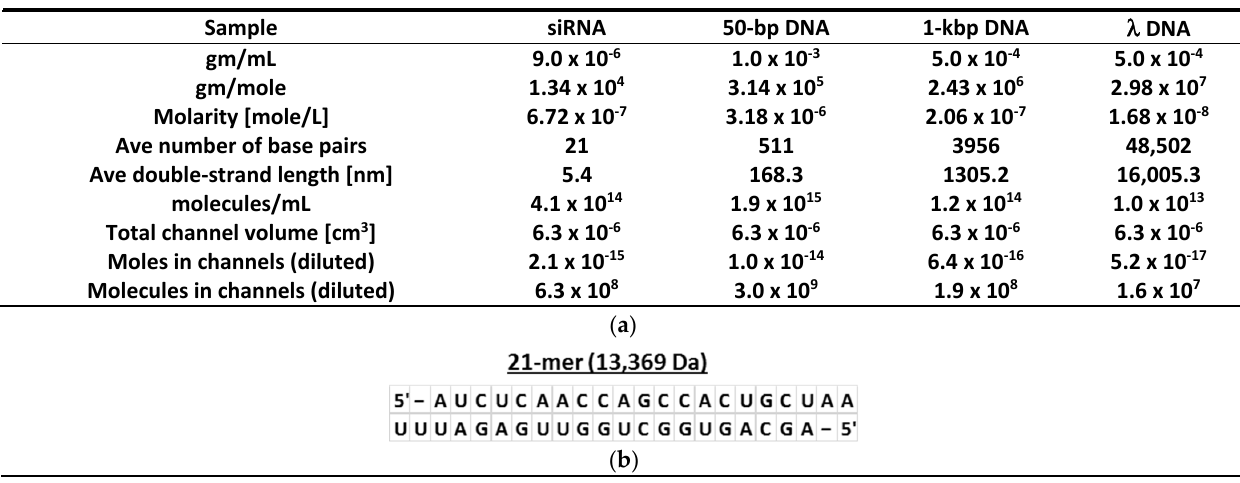
Figure 2. ( a ) Essential chemical and physical properties of four nucleic acid solutions, as provided by New England Biolabs, Inc., Ipswich, MA, USA, and after 50% dilution in the nanochannels. ( b ) Exact base sequence of the 21-mer fragments of the si-RNA sample including 5 ′ overhangs on opposite ends (A, C, G, and U stand for adenine, cytosine, guanine, and uracil, respectively).